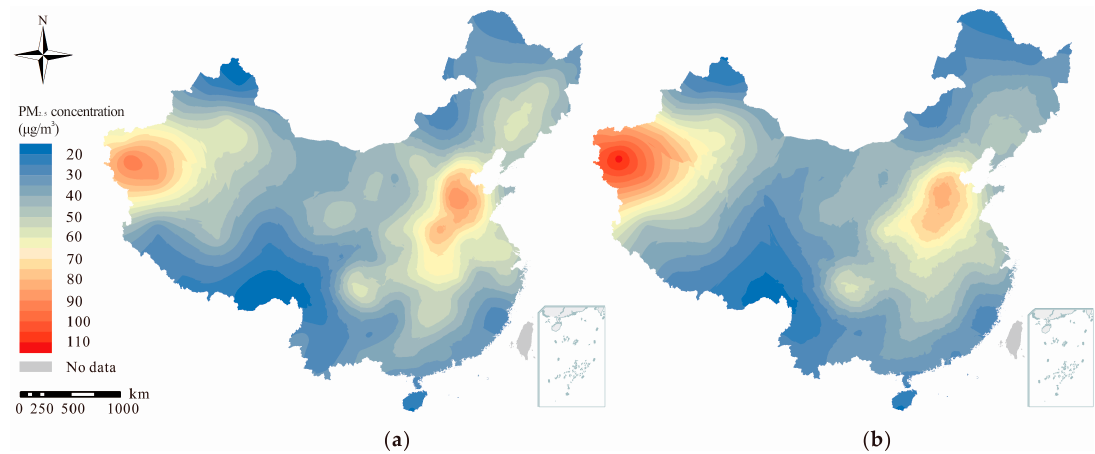
Figure 2. Spatial distribution of the annual fine particulate matter (PM 2.5 ) concentration in 2015 ( a ) and 2016 ( b ) across China.